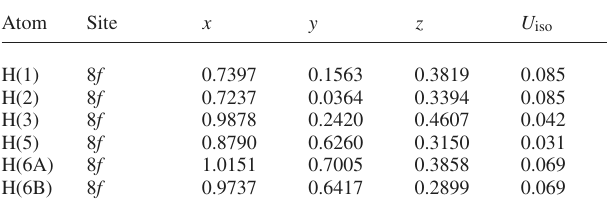
Table 2. Atomic coordinates and displacement parameters (in Å 2 )